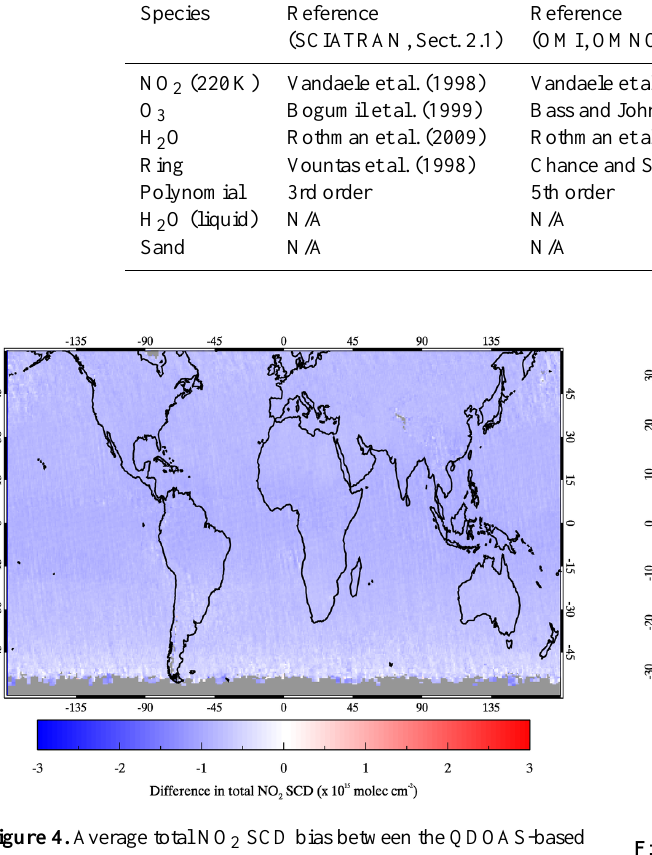
Figure 5. The normalised magnitude of the bias between the to- tal NO 2 SCD retrieved using the OMNO2A algorithm and the QDOAS-based solar reference retrieval. Cloud-free pixels (cloud fraction <25%) were compared. The Earth radiance L1B data was taken from orbit no. 06644.